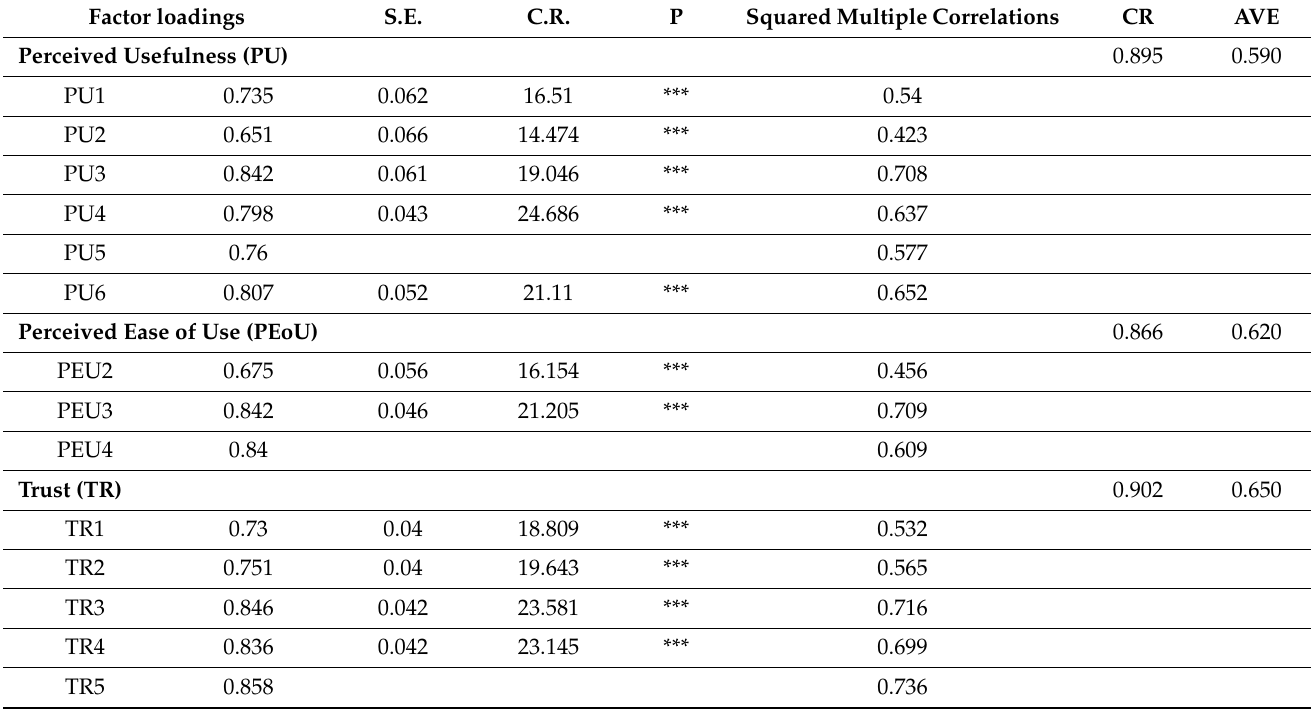
Table 5. Properties of the final measurement